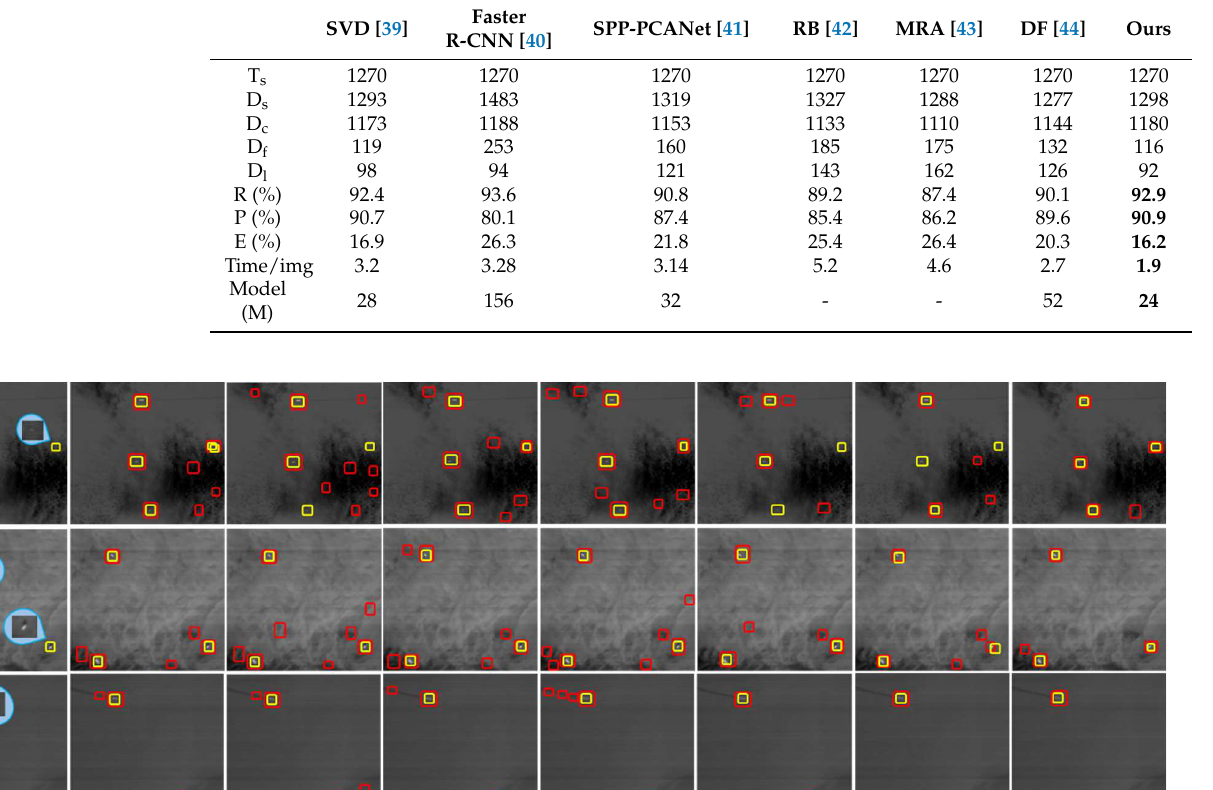
Table 3. Performance comparison results of the different algorithms.